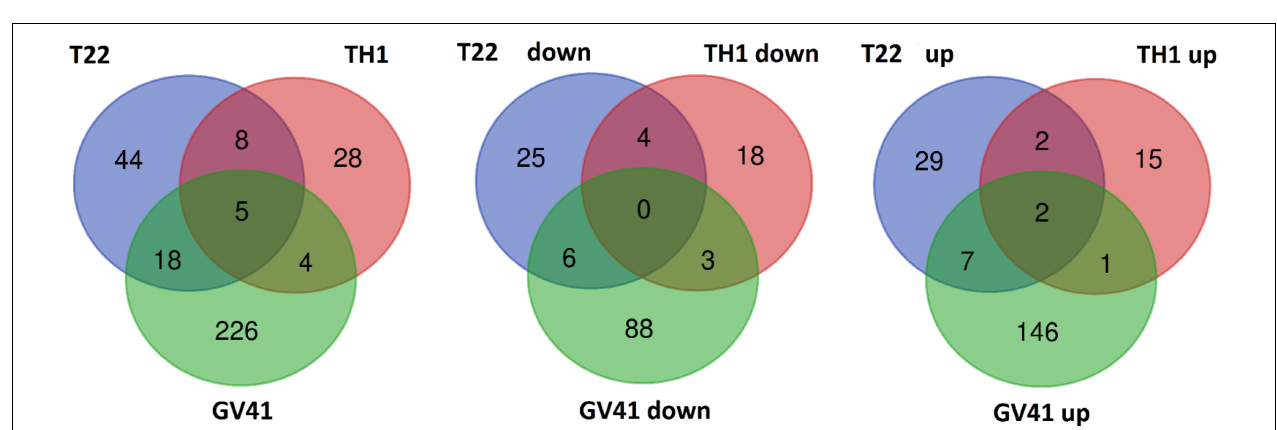
FIGURE 1 | Concentration of individual anthocyanins in strawberry fruits produced by plants subjected to the treatment with Trichoderma strains (T22, TH1, and GV41), as compared to control (CTR). Results on cyanidin 3 -O -glucoside (cya 3 -O -glc), pelargonidin 3 -O -glucoside (pel 3 -O -glc), pelargonidin 3 -O -rutinoside (pel 3 -O -rut), pelargonidin 3 -O -malonyl-glucoside (pel 3 -O -mal-glc), pelargonidin 3 -O -acetyl-glucoside (pel 3 -O -ac-glc) and cyanidin derivative (cya der) are shown. Data were reported as µ g/g sample, and represent the mean value of 8 biological replicates ± standard deviation (SD). Different letters on the bars indicate statistically significant differences ( P < 0.05).